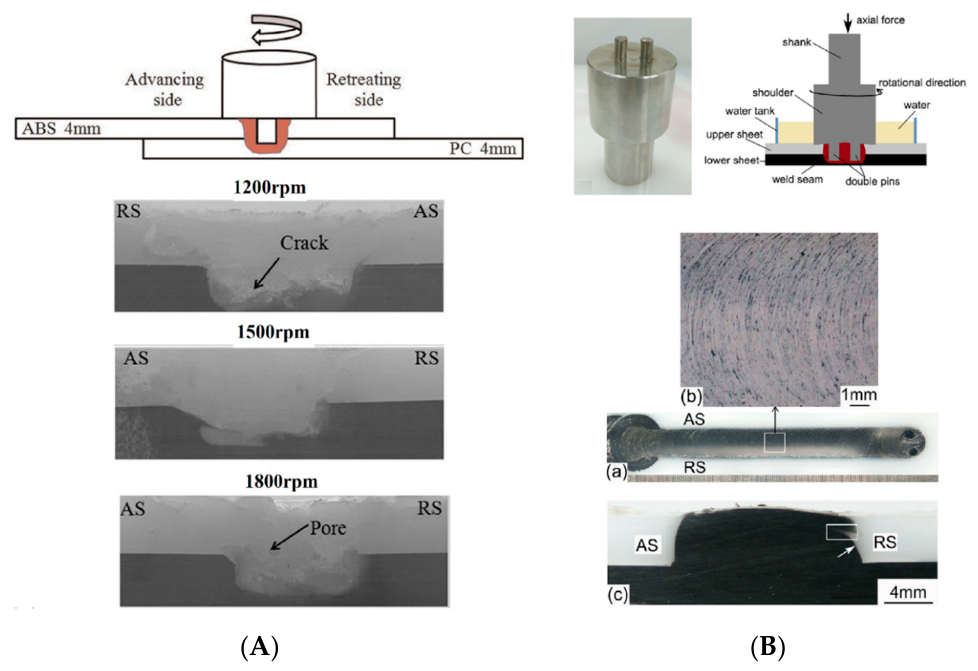
Figure 18. Underwater LFSW of ( A ) ABS-PC dissimilar joint [59] and ( B ) HDPE [60]. Figure 18. ( A ) E ff ect of process parameters on underwater LFSW of ABS-PC dissimilar joint [59] and ( B ) e ff ect of the double pin in underwater FSW of HDPE sheets